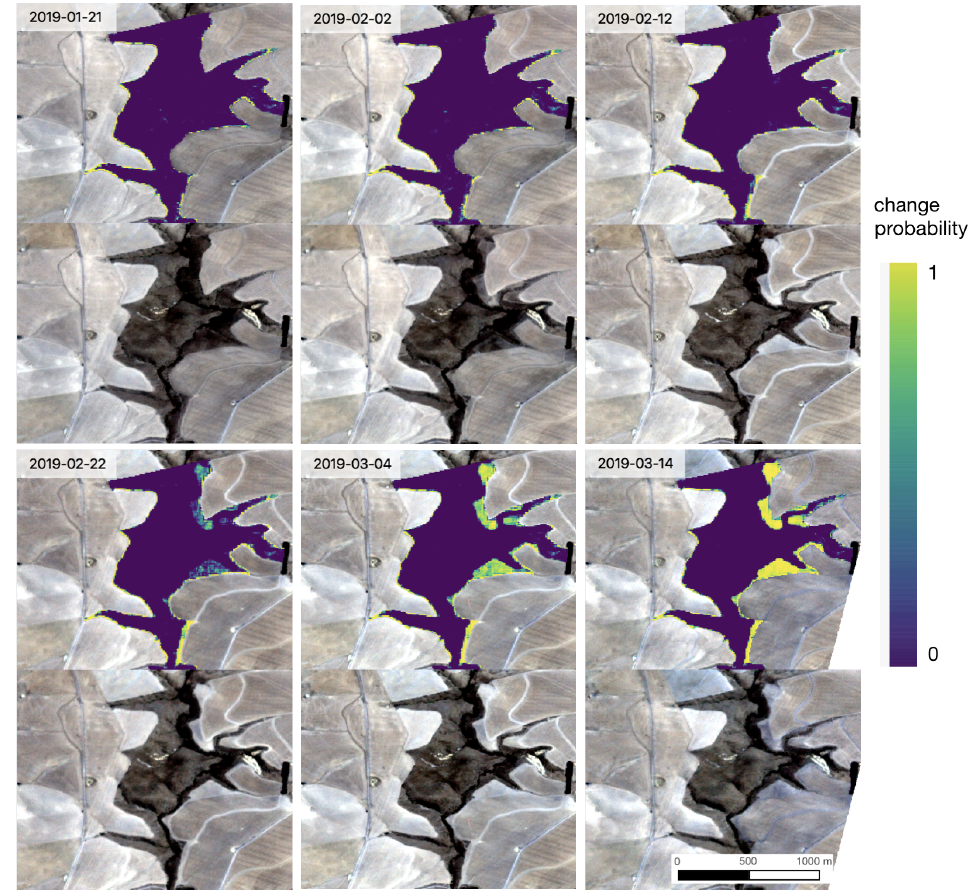
Figure 5. Example sequence of predictions through the course of a land cover change event in Renosterveld shrublands of the Overberg region, South Africa centered at 34.33 ◦ S, 19.68 ◦ E . Upper panels show the predicted probability of land cover change, where predictions are only made in pixels known to have intact natural vegetation at the start of the monitoring period. The lower panels show the most recent Planet Labs Planetscope imagery collected prior to, or on the date for which predictions are made. The detection of Renosterveld loss along the eastern edge of the monitored area is apparent. This detection occurred within 10–20 days of the actual land cover change